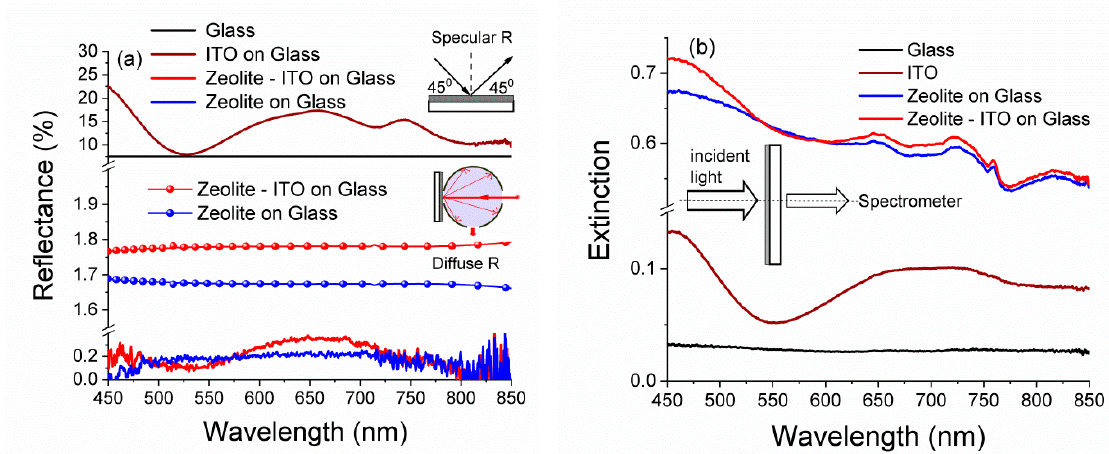
Figure 4. Spectra of ( a ) specular and diffuse reflectance and ( b ) extinction for the glass, nanofilms ITO, zeolite/glass, and zeolite/ITO/glass.